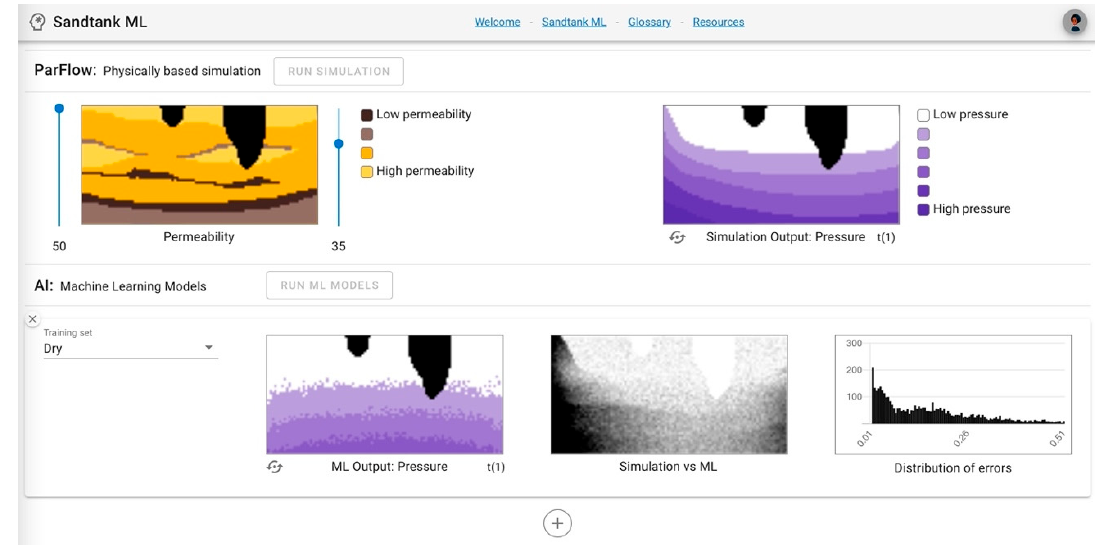
Figure 10. Display for user example 1 showing the boundary condition inputs, simulation output, and the associated ML pressure outputs using a dry training set.